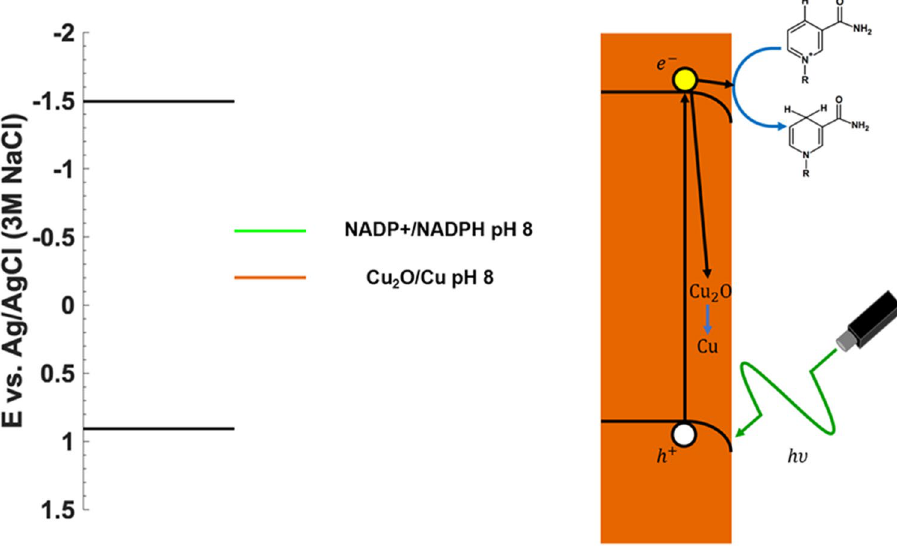
Figure 5. Band energy diagram. Schematic indicating redox potentials for NADP + and Cu 2 O reduction at pH = 8 relative to Ag/AgCl (3 M NaCl). The nickel layer, necessary for providing adsorbed hydrogen, is not